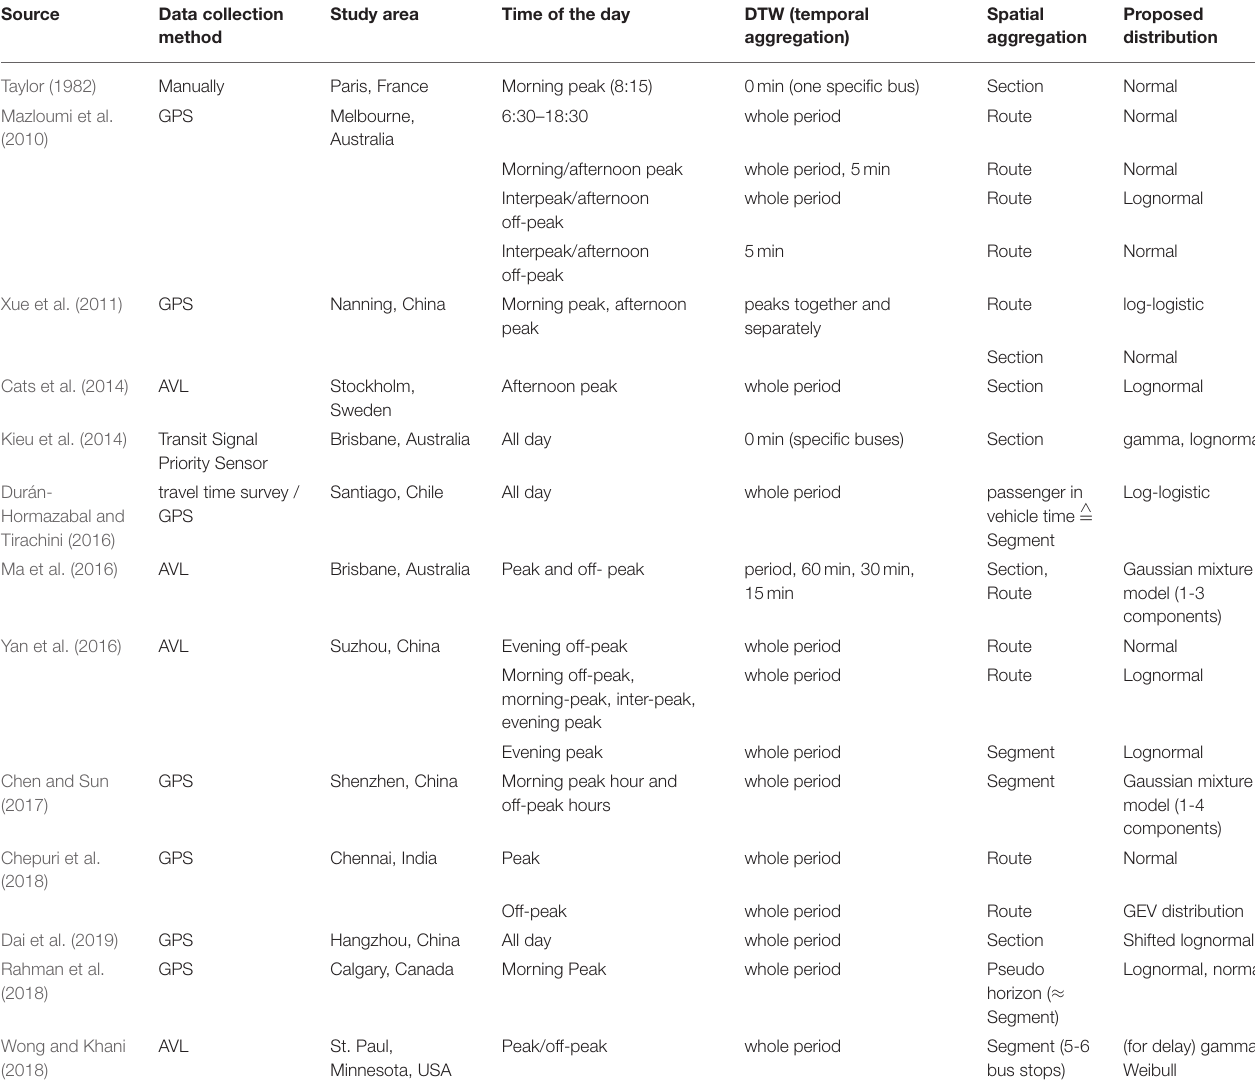
TABLE 1 | Compilation of studies examining travel